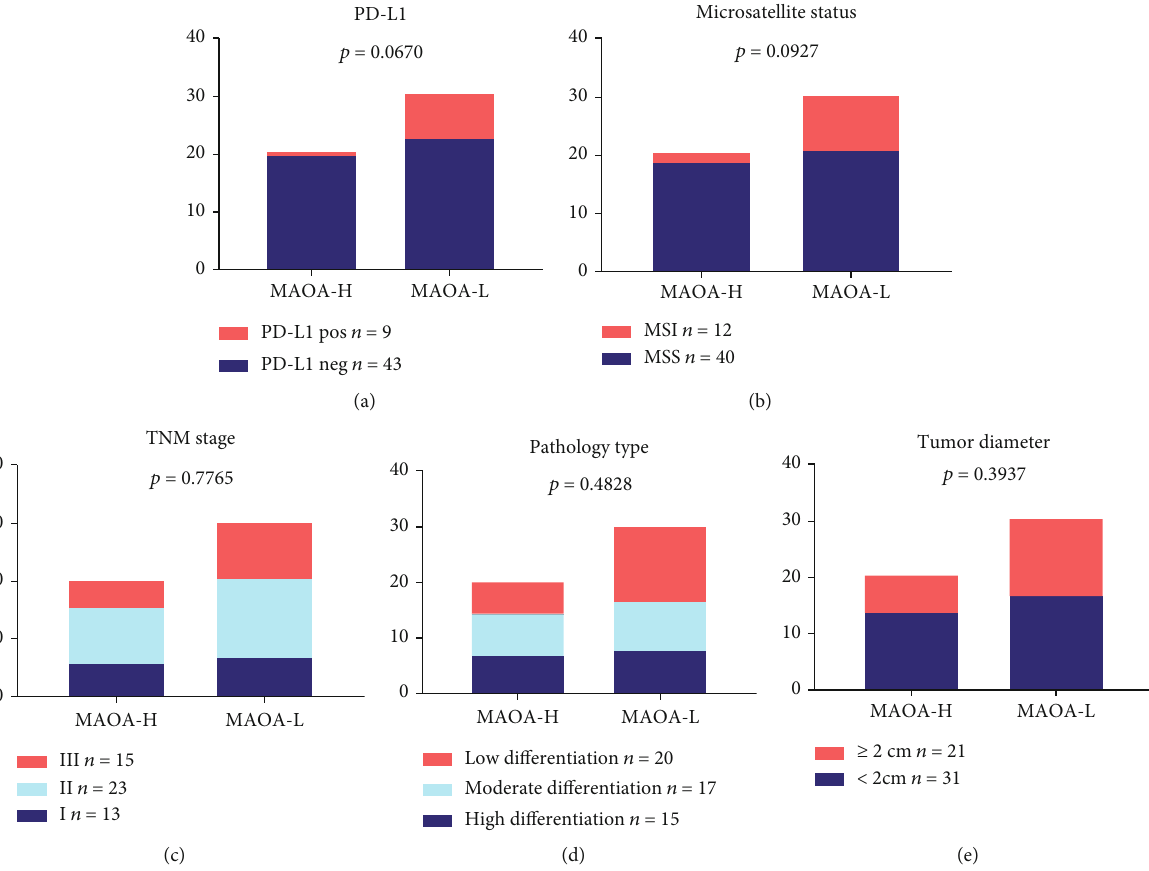
Figure 6: Correlation between MAOA expression and the patient clinicopathological characteristics. Patients with low MAOA expression had a larger ratio of PD-L1 positivity and MSI than those with high MAOA expression. Regarding the TNM stage pathology type and tumor diameter, no signi fi cant trends were found between the high- and low-expression